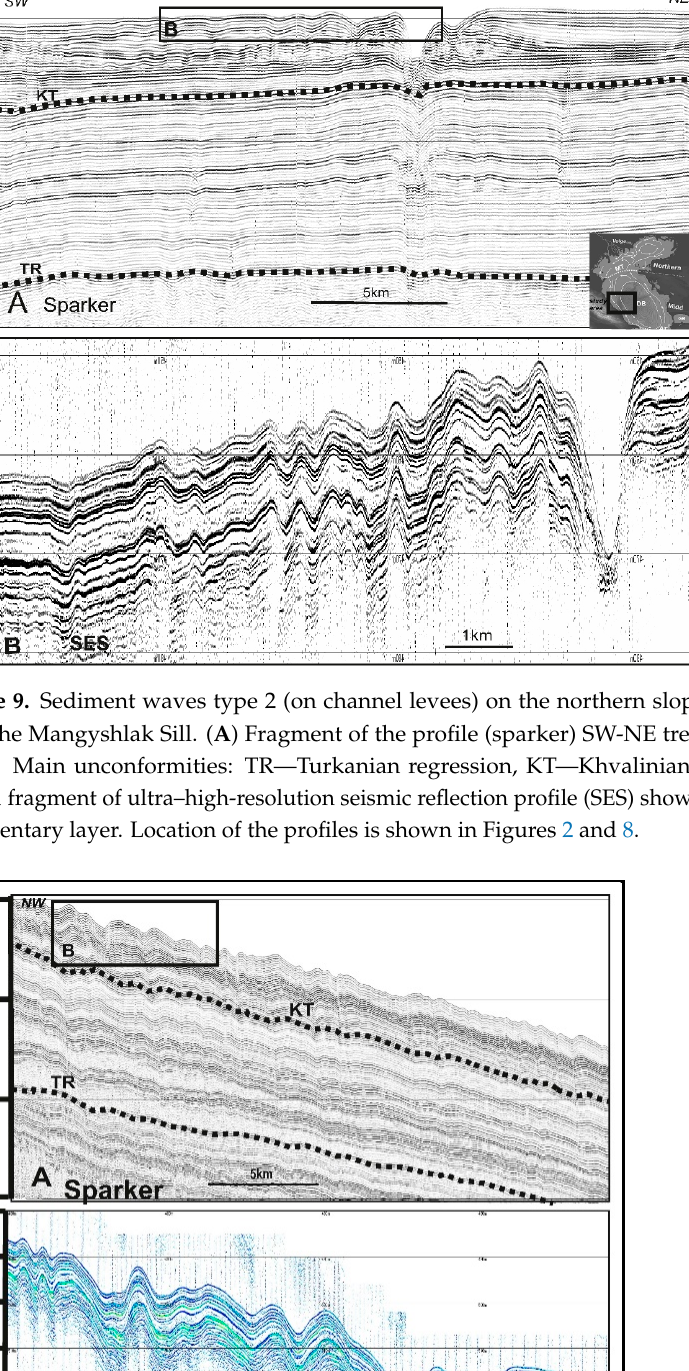
Figure 8. Scheme of modern channel system over the Mangyshlak Sill and contourites off the northern slope of the Middle Caspian Sea: sediment wave types 2 (on levee) and 3 (contourite) and abyssal drift. Lines 9, 10 and 11 show the positions of the seismic profiles shown in the corresponding figures.